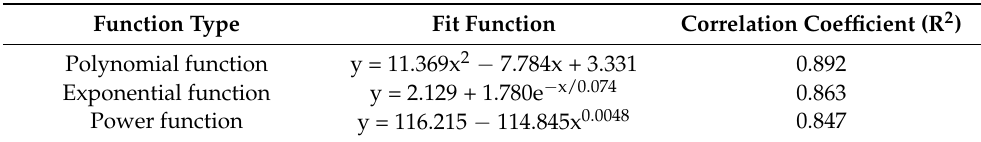
Table 6. Fitting results of the relationship between PSSA and tensile strength.